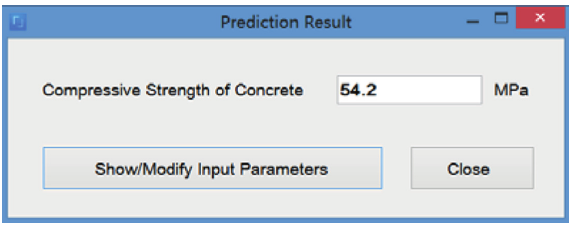
Figure 16: The results of compressive strength